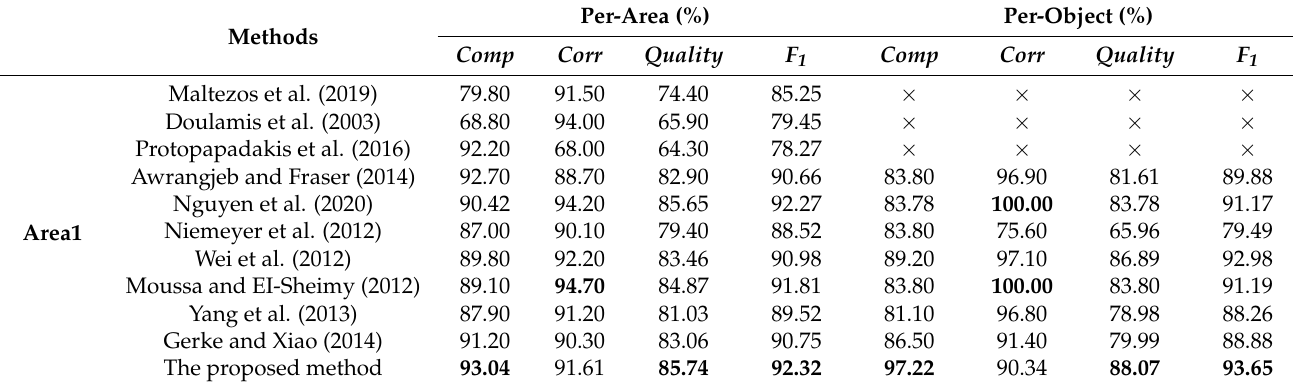
Table 1. Accuracy comparison of building extraction in Area1. The experimental results of the ten methods are obtained from the corresponding references. Bold font represents the highest value among the comparison results. “ × ” denotes that the results are not provided by the reference. Note that the methods proposed by Maltezos et al. (2019), Doulamis et al. (2003) and Protopapadakis et al. (2016) do not provide the completeness, correctness and quality at per-object level.